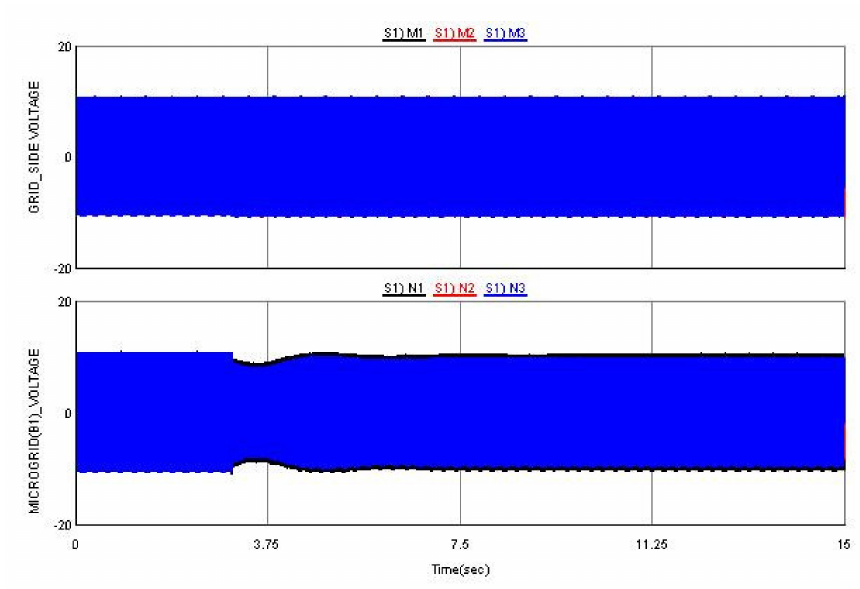
Figure 15. Microgrid voltage at the point of common coupling (PCC).